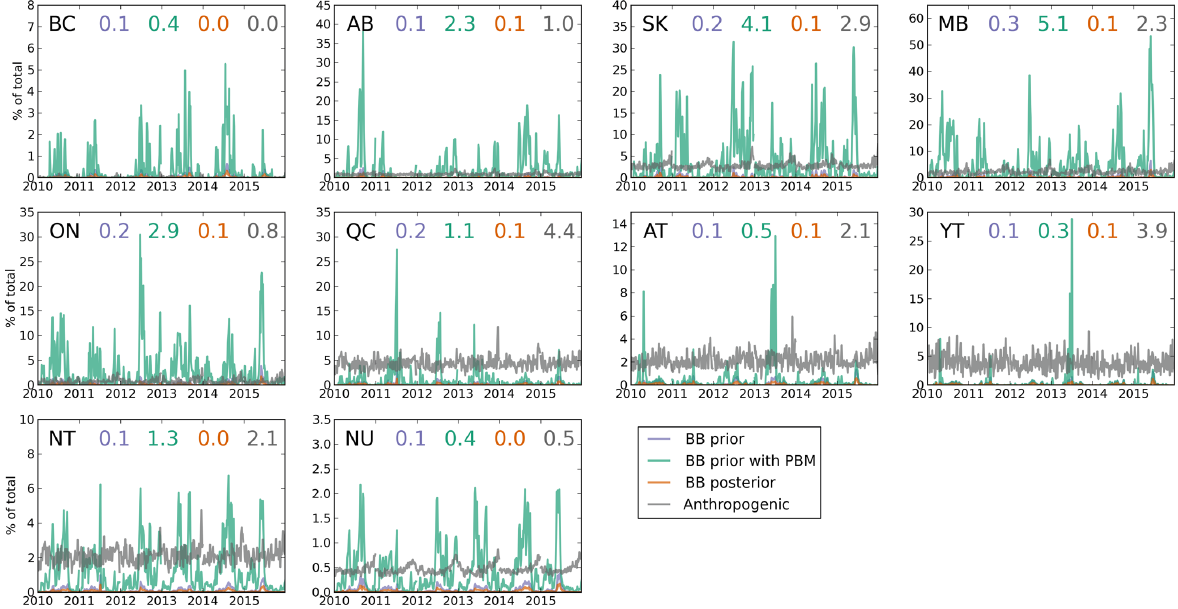
Figure 10. Same as Fig. 9, but for total surface TOM (GOM + PBM)